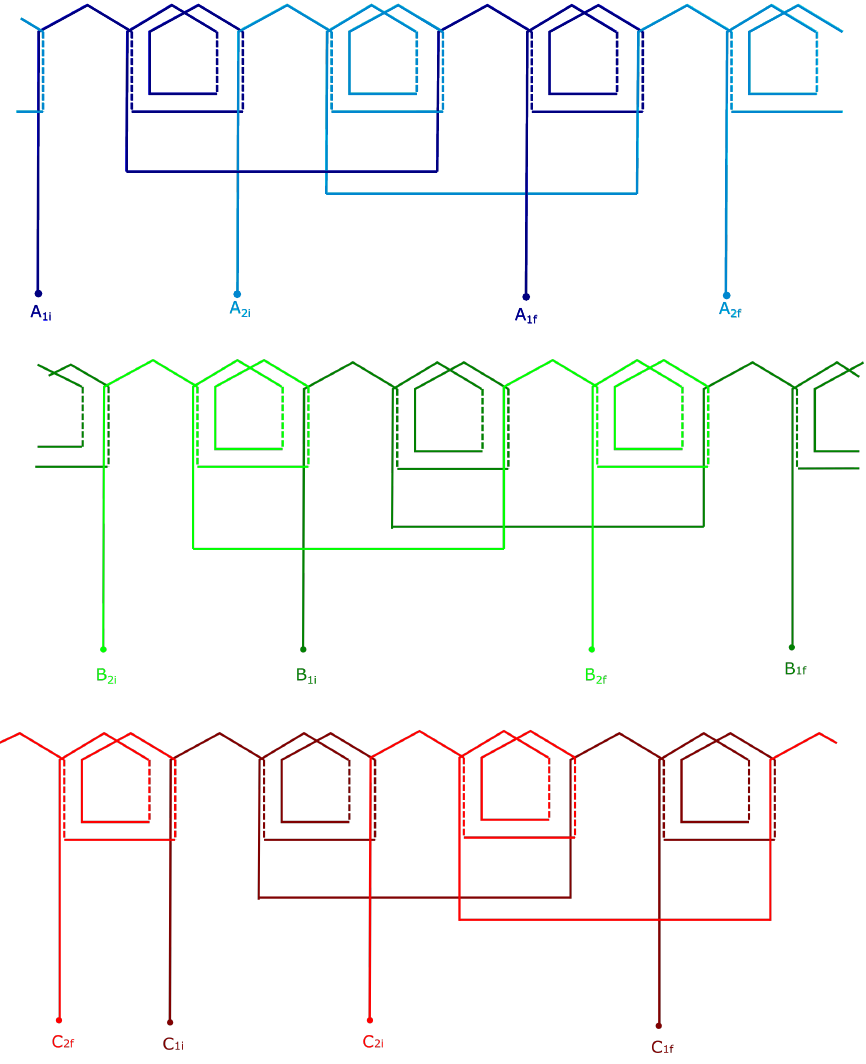
Figure 4. 8-pole winding connections. Figure 4. Eight-pole winding